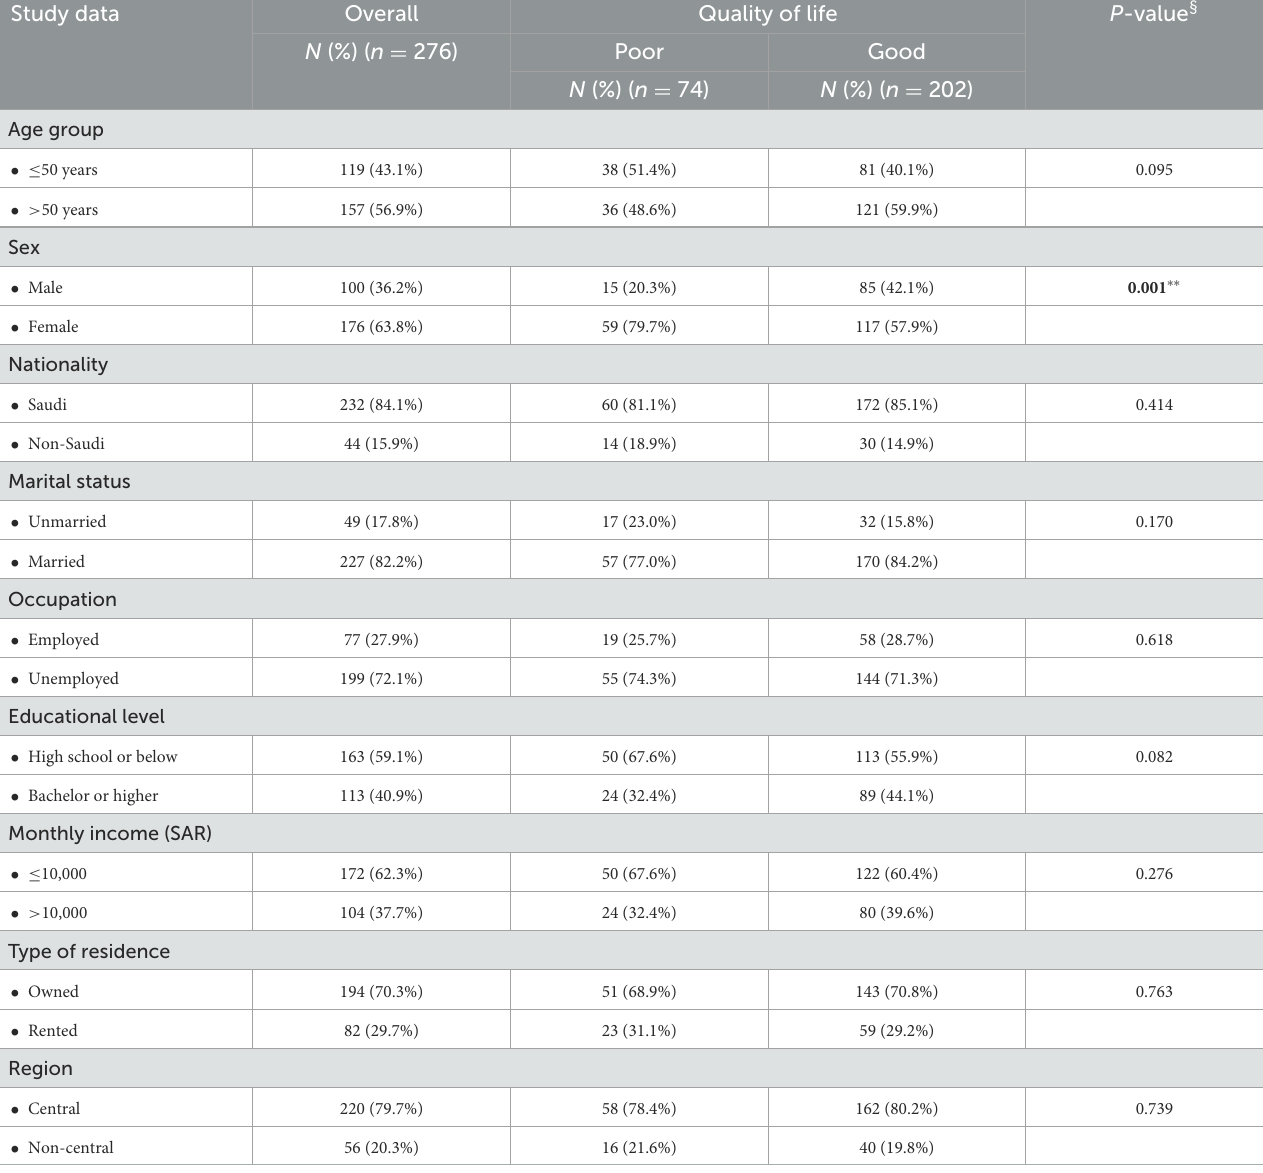
TABLE 1 Sociodemographic characteristics of the patients and their quality of life. Study